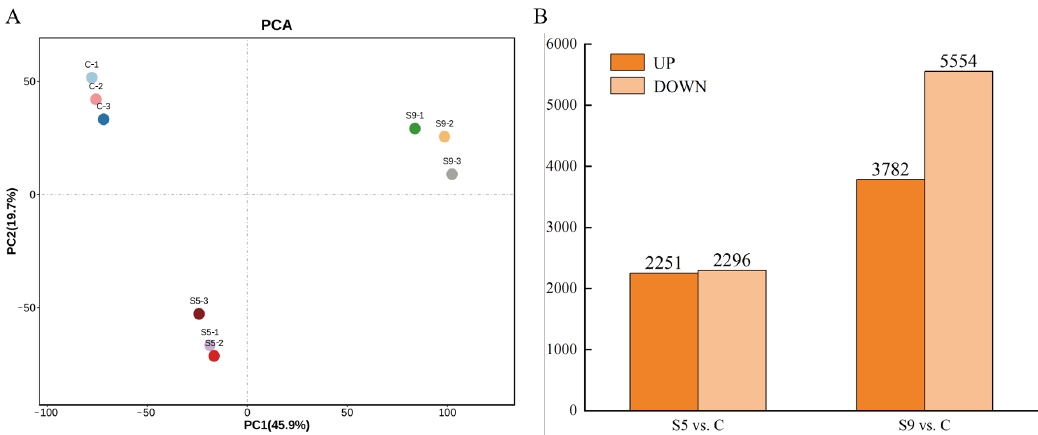
Figure 2. ( A ) Principal component analysis (PCA) of unigenes expression; ( B ) numbers of up- and downregulated DEGs in each comparison. (C: salinity 30 psu; S5: salinity 50 psu; S9: salinity 90 psu.)